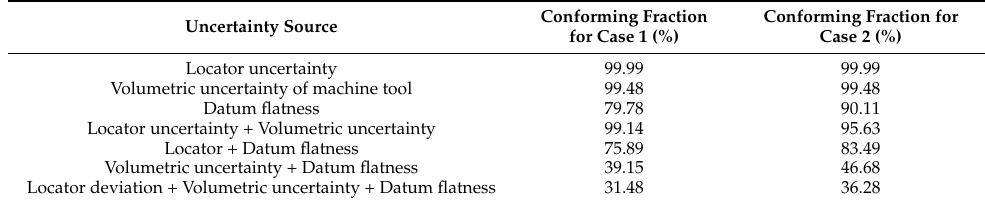
Table 2. Results of one drilled